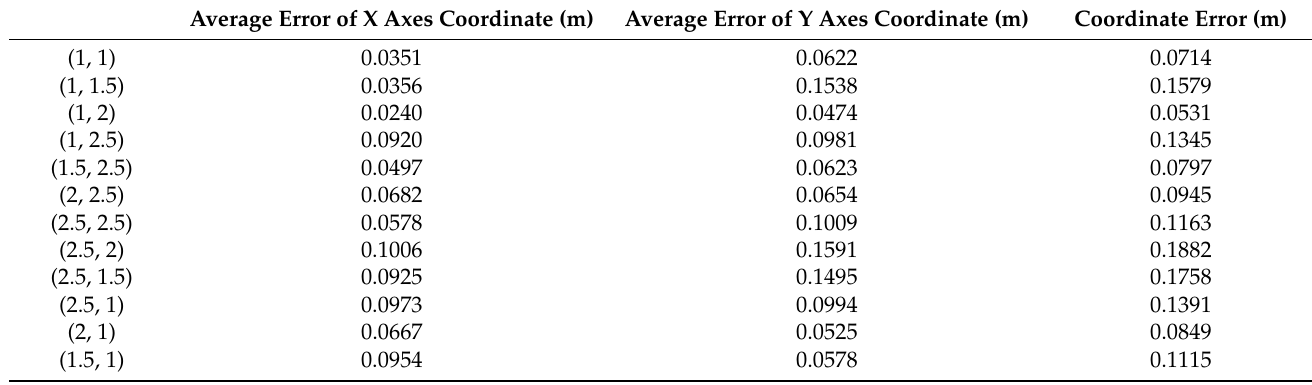
Table 4. Positioning error of each